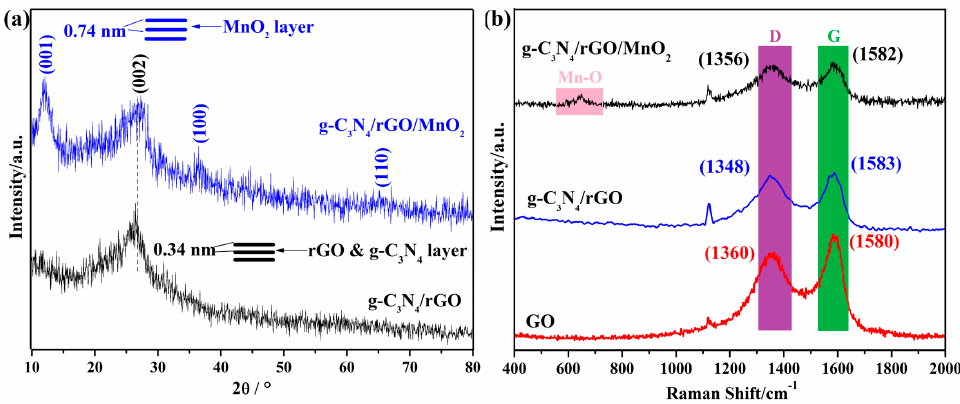
Figure 4. ( a ) XRD diffraction pattern of g-C 3 N 4 /rGO/MnO 2 ternary nanocomposite. ( b ) Raman spectra of GO, g-C 3 N 4 /rGO and g-C 3 N 4 /rGO/MnO 2 ternary nanocomposite.